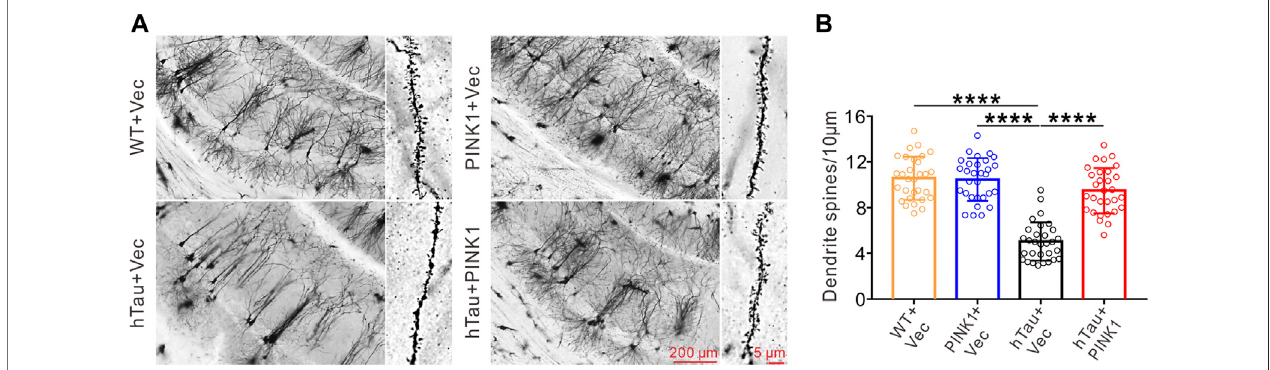
FIGURE 3 | PINK1 reverses the decreased dendritic spine density in the hippocampal CA1 region ofhTau mice. (A) Representative images of Golgi Staining in the hippocampal CA1 region of mice. (B) Quantitative analysis of spine density in the CA1 area of mice. Thirty neurons from each group were analyzed. One-way ANOVA followed by Tukey multiple-comparisons tests. **** p < 0.0001. All data were presented as mean ± SD. n (cid:2) 3 mice for each